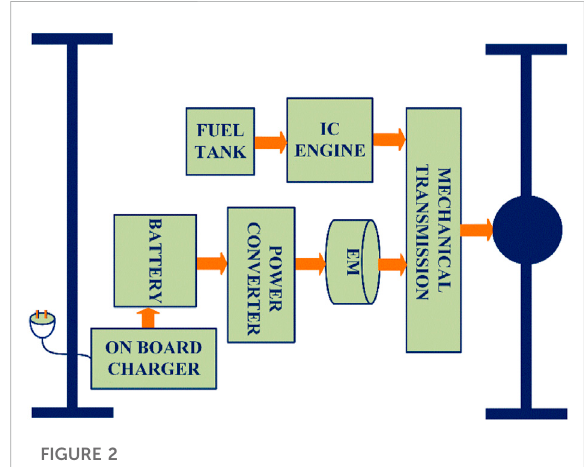
FIGURE 2 Plug-in hybrid electric vehicles (Ahourai et al.,